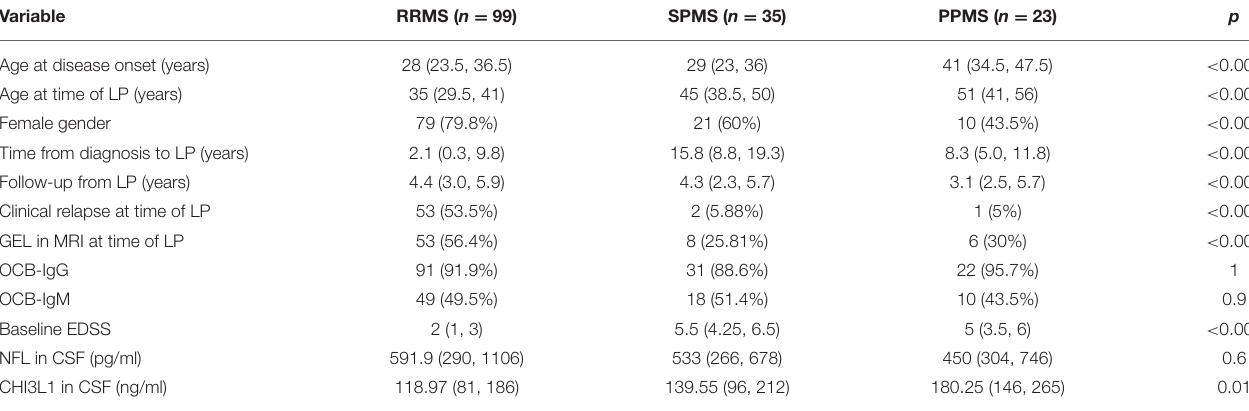
TABLE 1 | Demographics and CSF